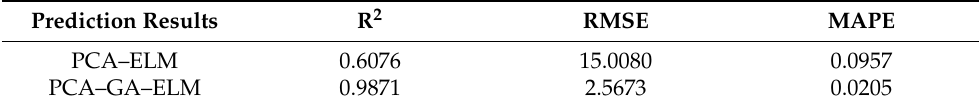
Table 4. Prediction error of the PCA–ELM and PCA–GA–ELM models. Prediction